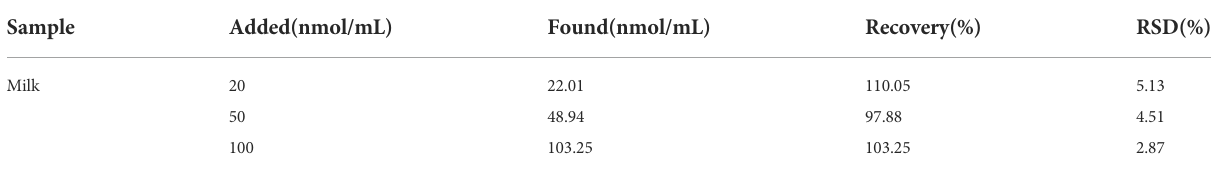
TABLE 2 Analysis of results of DEX in raw